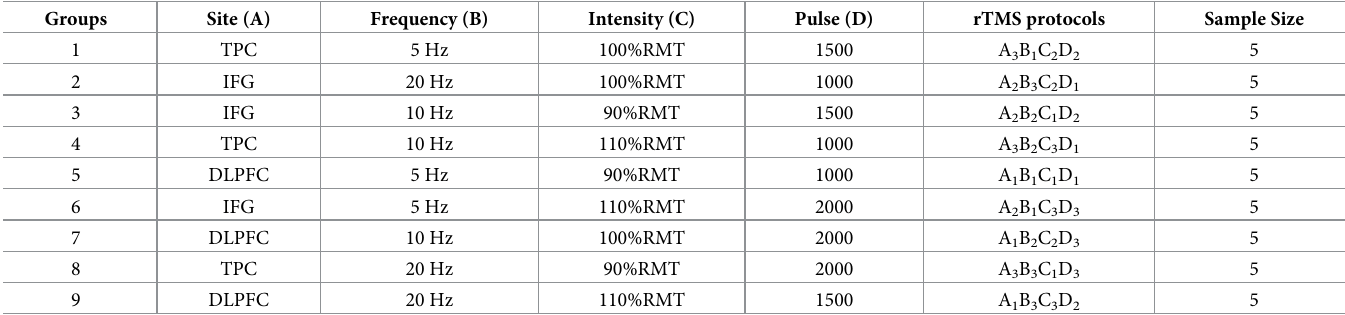
Table 2. The orthogonal array